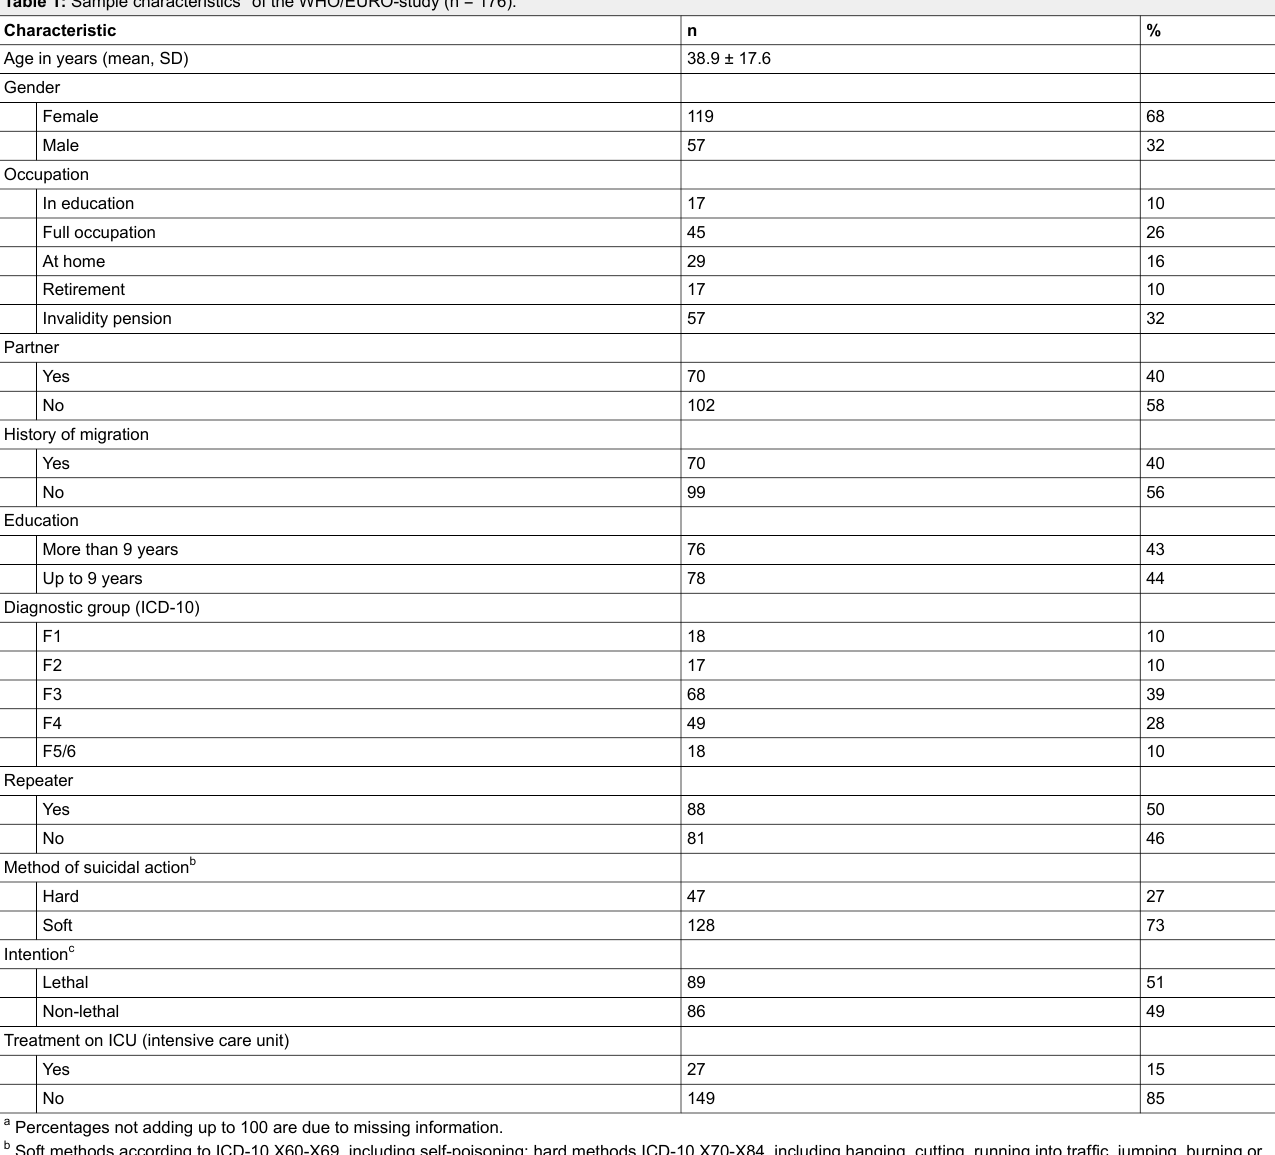
Table 1: Sample characteristics a of the WHO/EURO-study (n = 176).